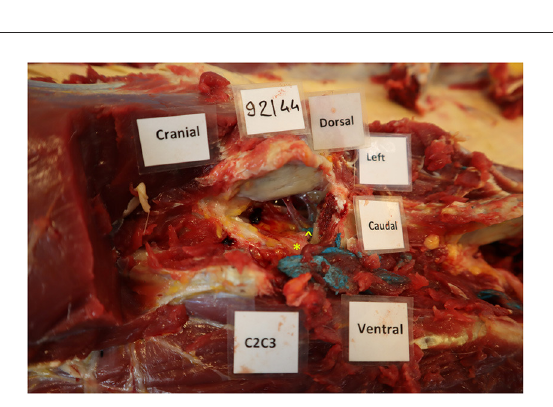
FIGURE4 Presence of blue latex within the vertebral canal at the level of C3. The left cranial and abaxial articular process of the 3 rd cervical vertebra was transected with an osteotome to visualize the vertebral canal. In this case, the latex was in contact with the nerve root (*) but a small amount was also present within the vertebral canal ( ∧ ), but outside of the dura